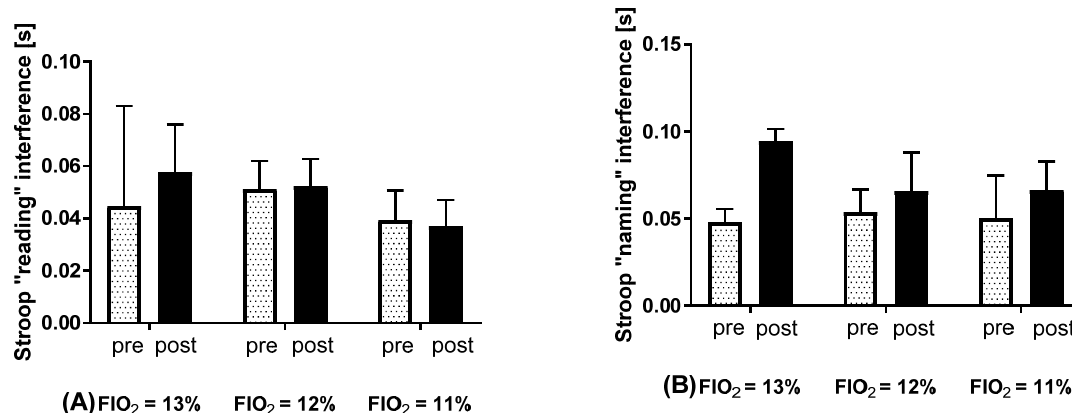
Figure 1. Effect of acute normobaric hypoxia at various simulated altitudes (a.s.l.) on post-exposure interference values in reading ( A ) and in naming ( B ). Values are means. Error bars indicate ± SEM (standard error of the mean).